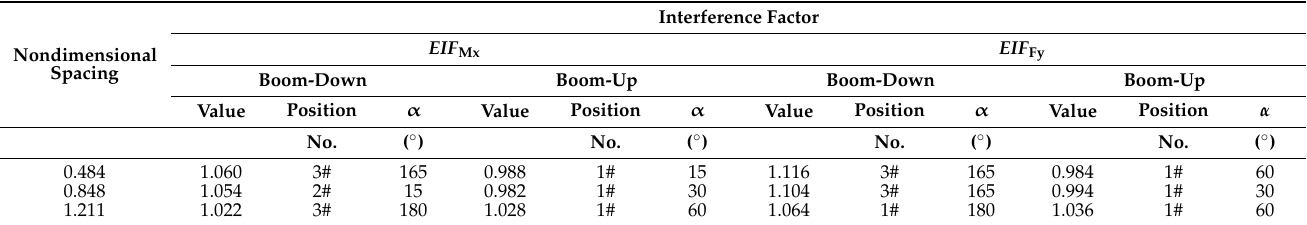
Table 7. Maximum EIF with different spacings.